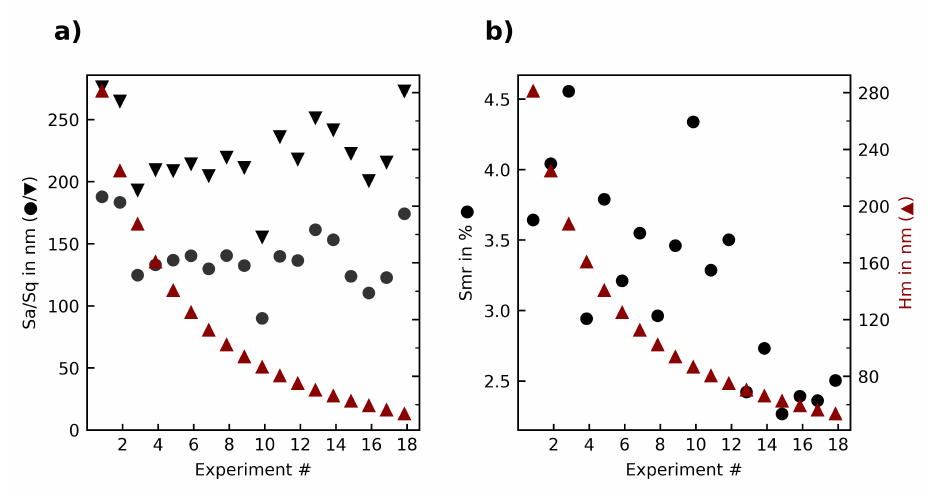
Figure 5. Overview of the ( a ) roughness parameters Sa, Sq; ( b ) surface bearing parameter Smr in relation to the median chip thickness Hm in the first experiment series.